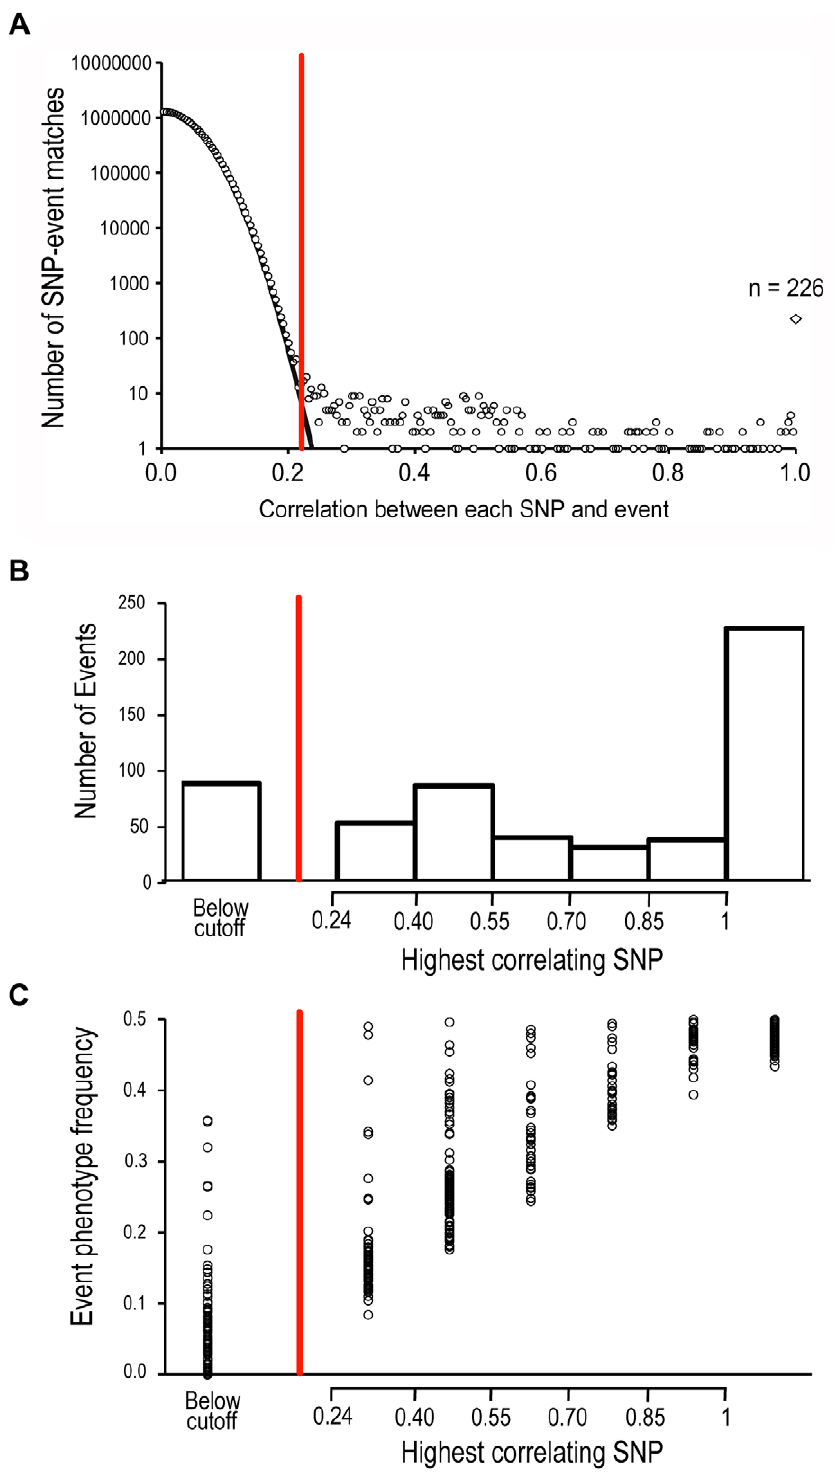
Figure 3. Most events are significantly correlated with one or more SNPs. A) Histogram of the correlation between every pair-wise event- SNP combination. A correlation of 1.0 (diamond marker) indicates perfect agreement between the SNP genotype and event phenotype in all intermediate genomes. The black line shows a theoretical binomial distribution of correlations between independent events and SNPs. B) Histogram showing the largest SNP-event correlation for each event. C) The event phenotype frequency, the fraction of intermediate genomes containing the less common phenotype of each event, binned as in B. For all graphs, the significance cutoff is shown by the red line.